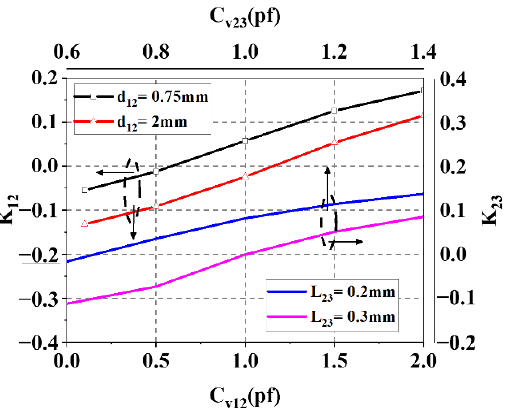
Figure 8. K 12 versus Cv 12 for different d 12 (left). K 23 versus Cv 23 for different L 23 (right).